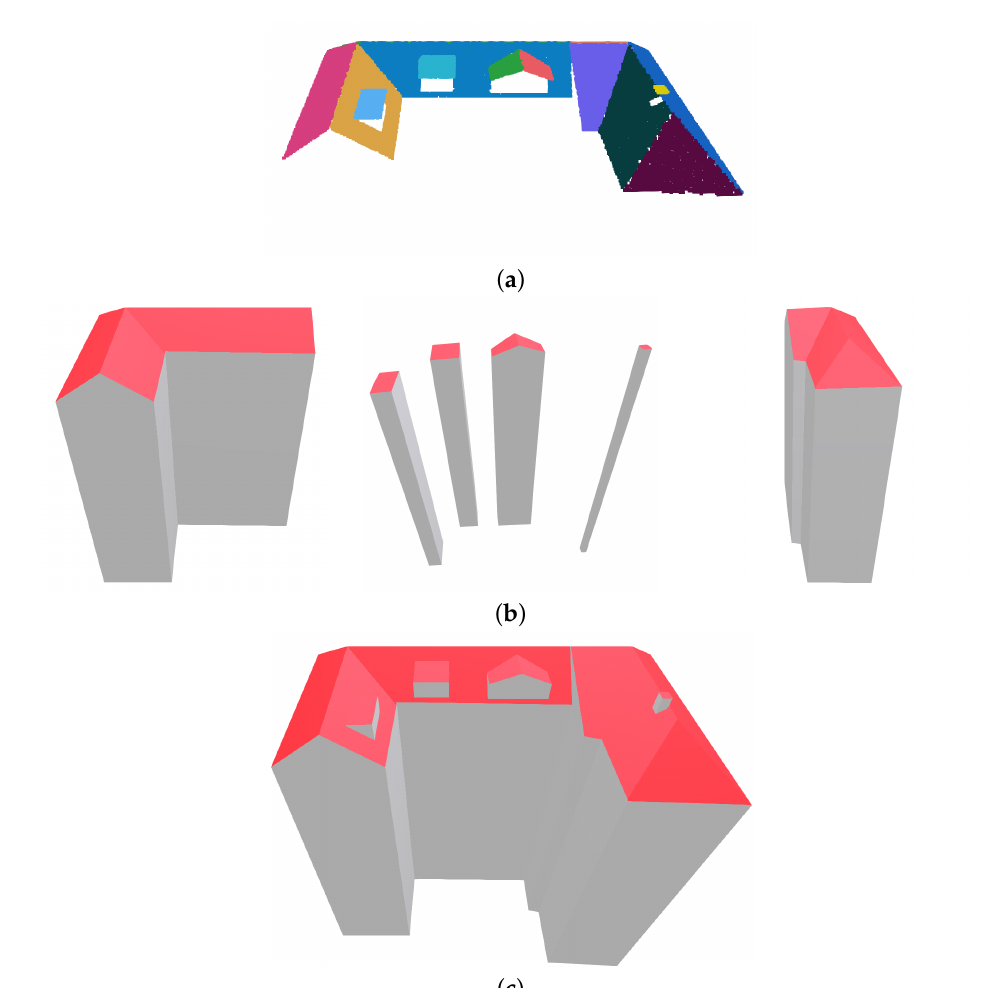
Figure 5. Illustration of generating building model, where the input half-spaces are shown on the top ( a ), the obtained sub-buildings are shown in the middle ( b ), and ( c ) shows the final building model that was obtained by a union of all